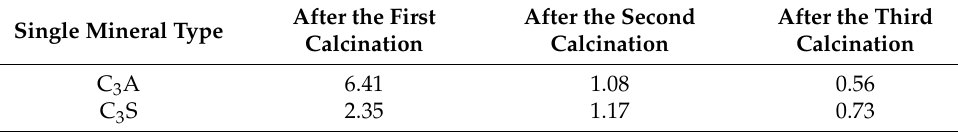
Table 2. f-CaO content in single mineral. (%). Single Mineral